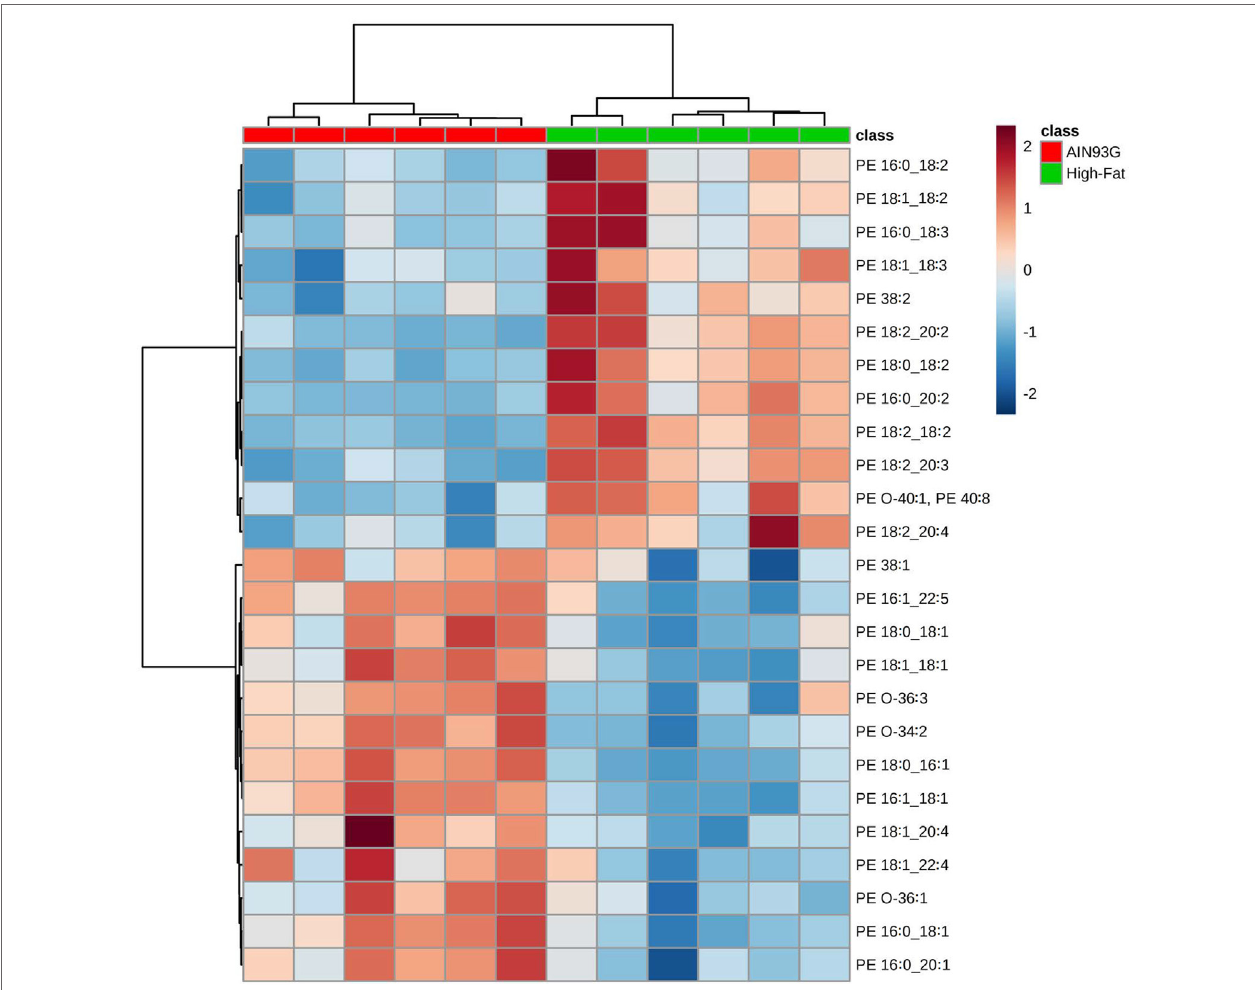
FigUre 5 | Hierarchical clustering heatmap analysis of phosphatidylethanolamine (PE) lipids in the primary tumor of Lewis lung carcinoma from mice fed the AIN93G diet or high-fat diet. Each colored cell on the map corresponds to a concentration value. The top 25 lipid species from the two diet groups are presented and ranked by t -tests to retain the most contrasting patterns. Values are measured by Euclidean distance with a Ward clustering algorithm ( n = 6 per group). * p ≤ 0.05 for each